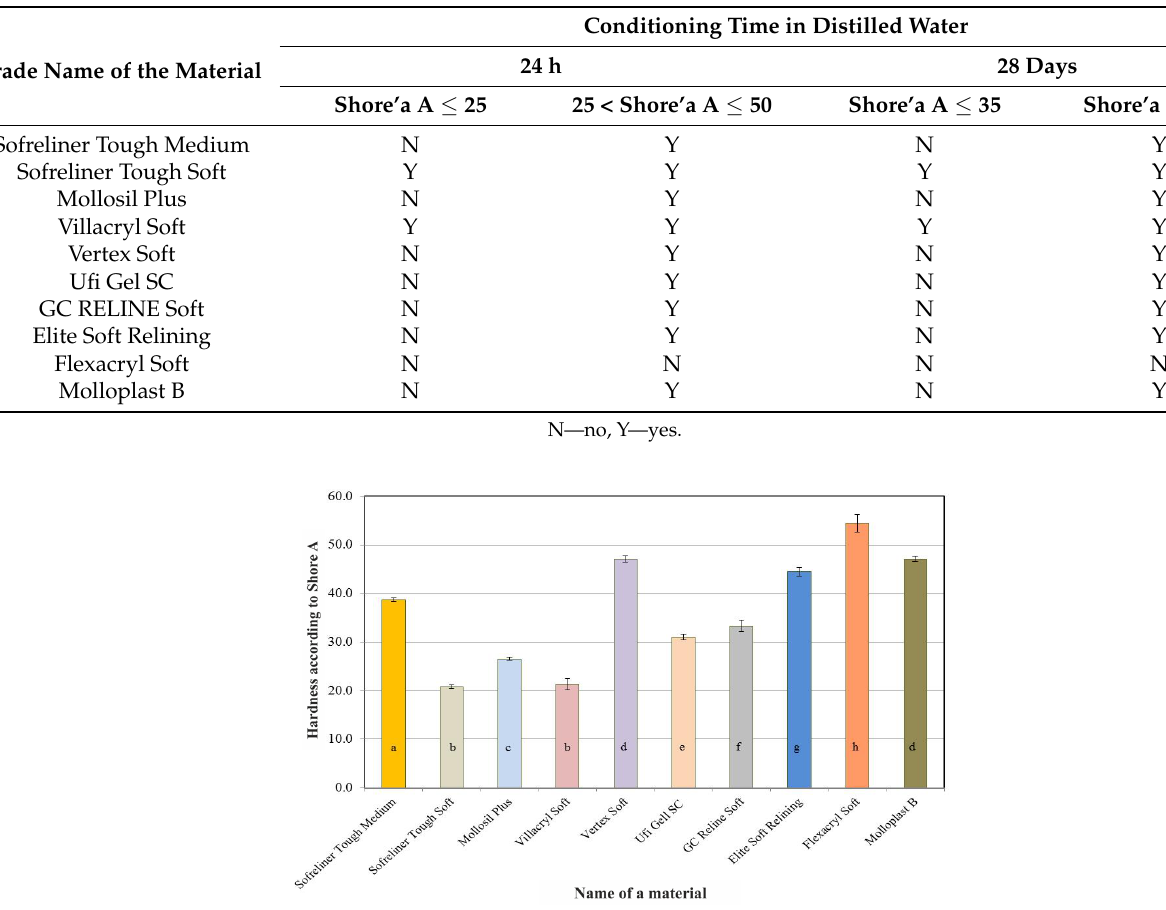
Table 1. Comparison the degree of meeting the requirements of ISO 10139-2 for the test materials in the light of the criteria for classification of soft relining material as soft or super soft.